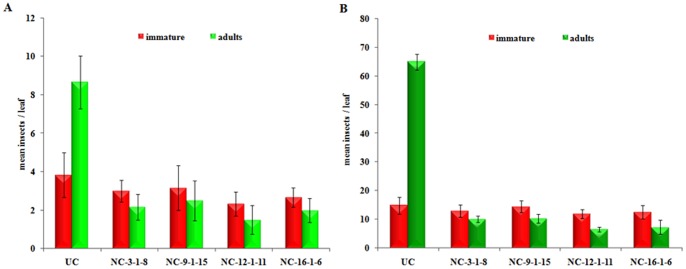
Effect of ASAL on the development of jassid and whitefly insects.(A) Twenty jassid nymphs were released onto each single leaf enclosure. After 21 days, the number of nymphs reached adult stage and the number of nymphs remained immature were plotted on the graph. (B) One adult whitefly pair was released onto each single leaf enclosure and after 32 days the number of nymphs reached adult stage and the number of nymphs remained immature were plotted on the graph. UC: untransformed control plants. NC3-1-8, NC9-1-15, NC12-1-11 and NC16-1-6: Different transgenic cotton lines expressing ASAL. Bioassays were carried out with five replications and were repeated thrice. Differences between control and transgenic plants were significant at p<0.0001. Bars indicate mean ± SE.